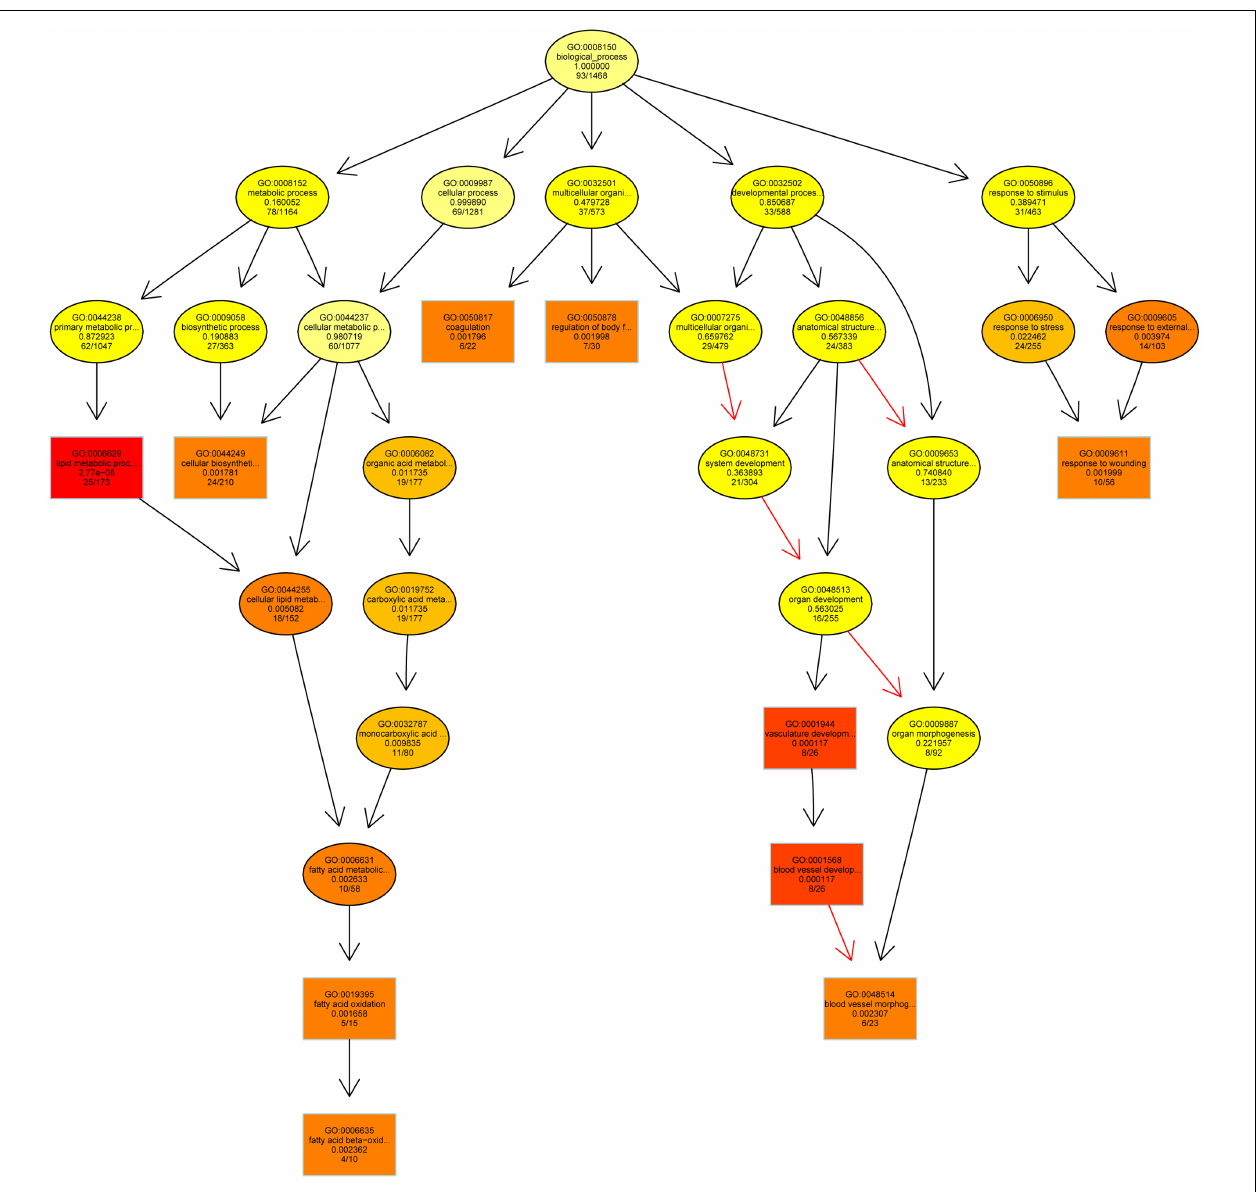
FIGURE 4 |Acyclic graph resulting from the EnrichmentAnalysis and showing the biological processes mostly affected by an interaction between sample type (Soil, Extract) and treatment (NOEC, DiR).